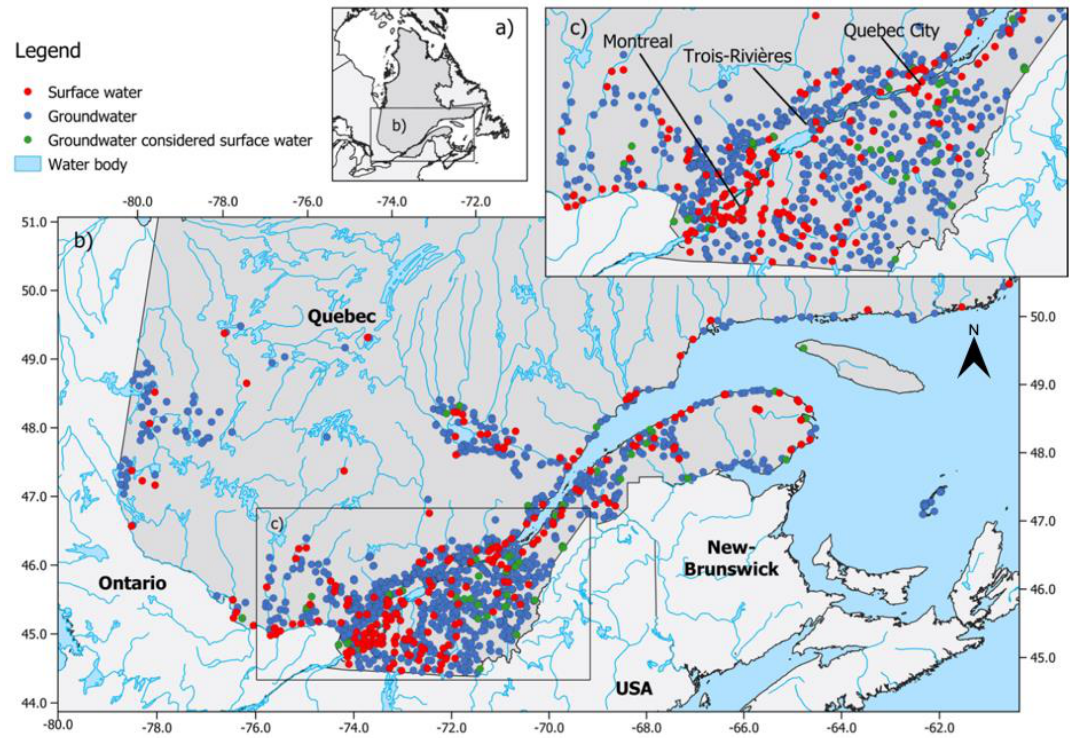
Figure 1. Spatial distribution of municipal drinking water sources. The water sources are classified into three categories, i.e., groundwater (in blue), surface water (in red), and groundwater considered surface water (in green). ( a ) overview of the study area; ( b ) view of the distribution of all wells throughout the province; ( c ) view of the most densely populated area of the province along the Saint-Lawrence River